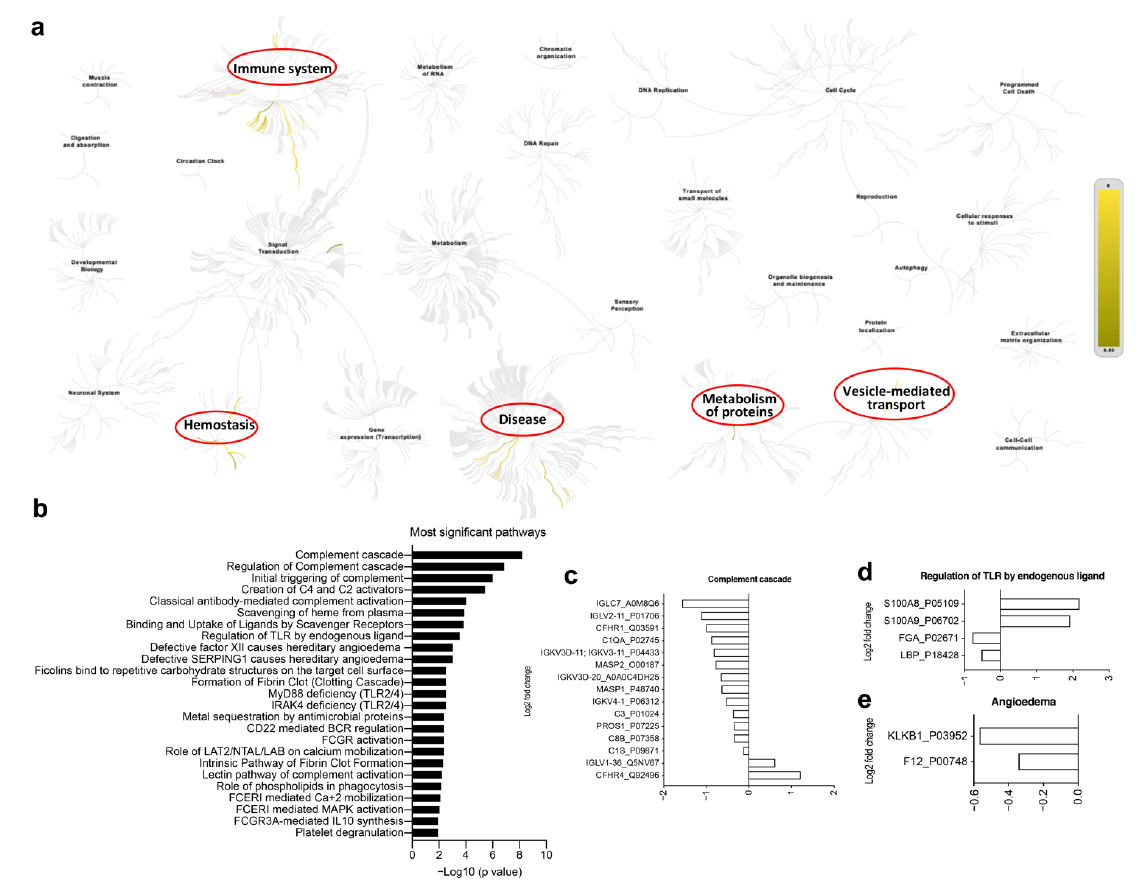
Figure 6. Human serum proteomics of vaccination-related or COVID-19-recovered samples. ( a ) The hierarchical genome-wide overview of the reactome of serum proteins in vaccinated participants, which were significantly enriched in immune system, hemostasis, disease, metabolism of proteins and vesicle-mediated transport. ( b ) The 25 most relevant pathways, sorted by p values, were significantly enriched in complement-related pathways. ( c – e ) Differential gene expression of complement cascade ( c ), regulation of TLR by endogenous ligands ( d ) and angioedema ( e ). The lipidomics analysis revealed that there was a significant decrease in phosphati- dylglycerol (PG) and lysophosphatidylcholine (LPC) (Figure 7a,b), a known inhibitor of the viral membrane fusion, which can prevent the entry of the virus into the host cells, indicating similar LPC change with virus infection. LPC can also induce the migration of lymphocytes and macrophages, increase the production of pro-inflammatory cytokines, and aggregate inflammation, which could increase the body’s inflammatory response level to resist virus invasion [35]. However, a significant increase in phosphatidylcholine (PC), phosphatidylethanolamine (PE), phosphatidylserine (PS), and monogalactosyldi- acylglycerol (MGDG) was observed after vaccination (Figure 7b). Those above changes were consistent with recovered patients, especially both at the late stage of vaccination and the recovered group. The results showed that the CoronaVac could induce similar lipids changes as the recovery participants. In the metabolomics analysis, both LPC and PC changes displayed consistent lipidomic changes. In addition, bile acids, cholestane steroids, carbohydrates, tricarboxylic acid cycle-related metabolites, and ketoacids-related metabolites showed a decreasing trend after vaccination and in convalescent participants, while amines, purine metabolites, and bilirubin increased in the late stage of vaccination